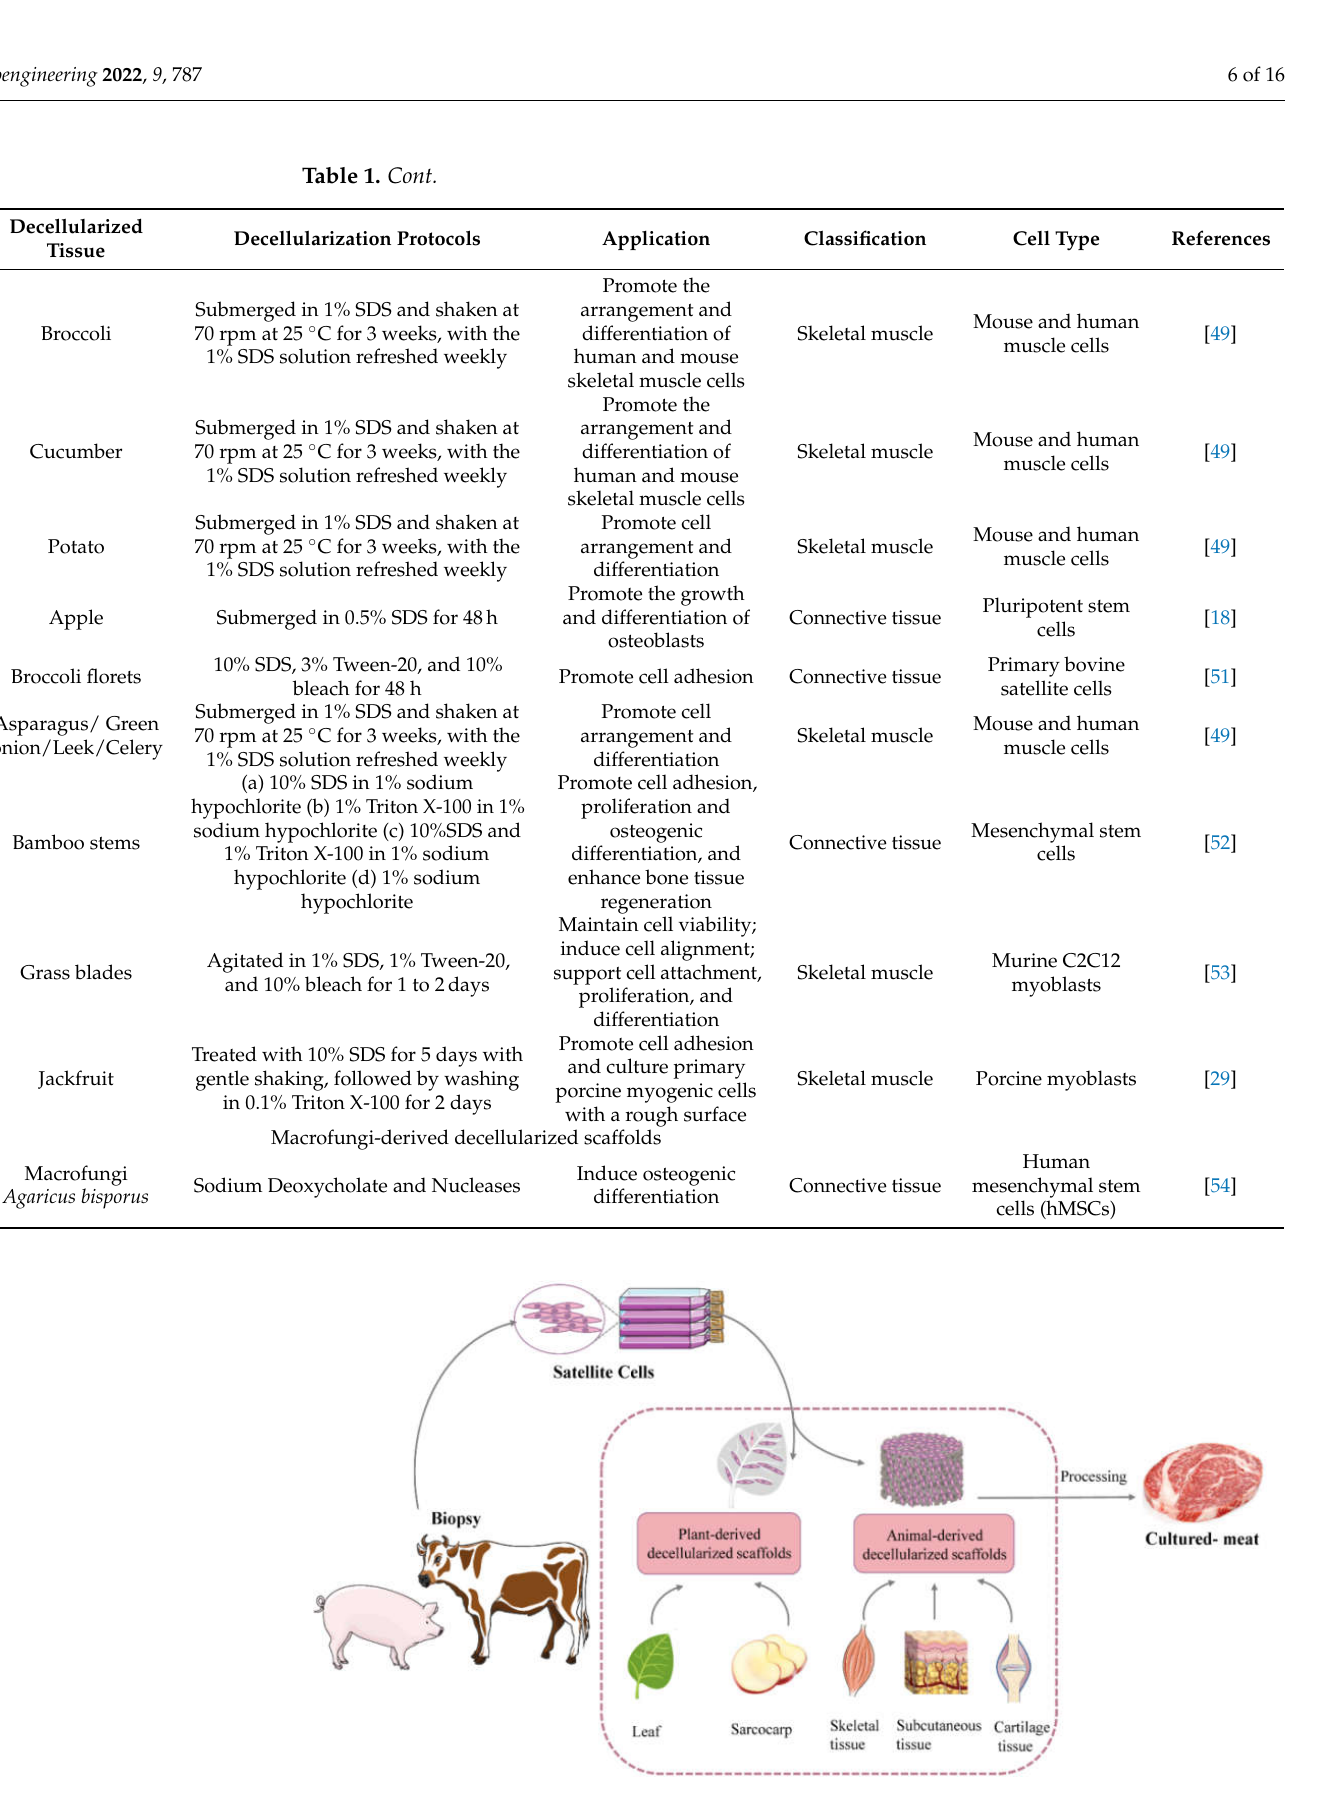
Figure 1. Schematic of cultured meat produced from decellularized scaffolds.